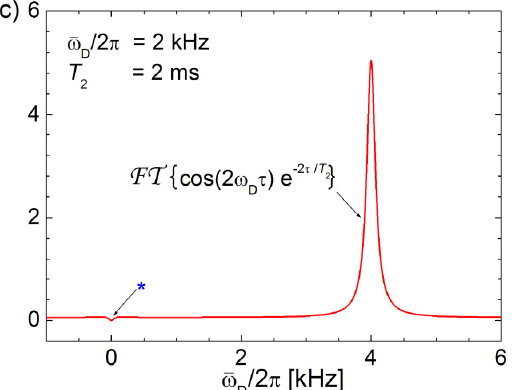
Figure 3. ( a ) Simulation of the normalized DQ build-up curve described by Equation (6) with a single residual dipolar coupling ω D /2 π = 2 kHz and an effective relaxation time T ∗ = 2 ms; ( b ) the Fourier spectrum of the DQ signal shown in ( a ) and ( c ) the corrected DQ Fourier spectra from ( b ). The star symbol showed the error in the transformed spectra due to the correction procedure.